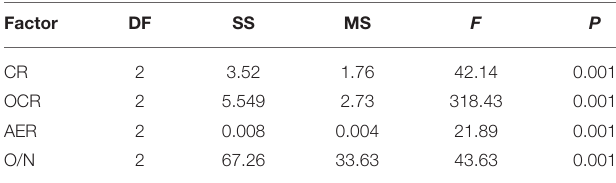
TABLE 3 | Analysis of variance (ANOVA) test of clearance rate, oxygen consumption rate, ammonia excretion rate, and O/N rate of P. f. martensii in the three